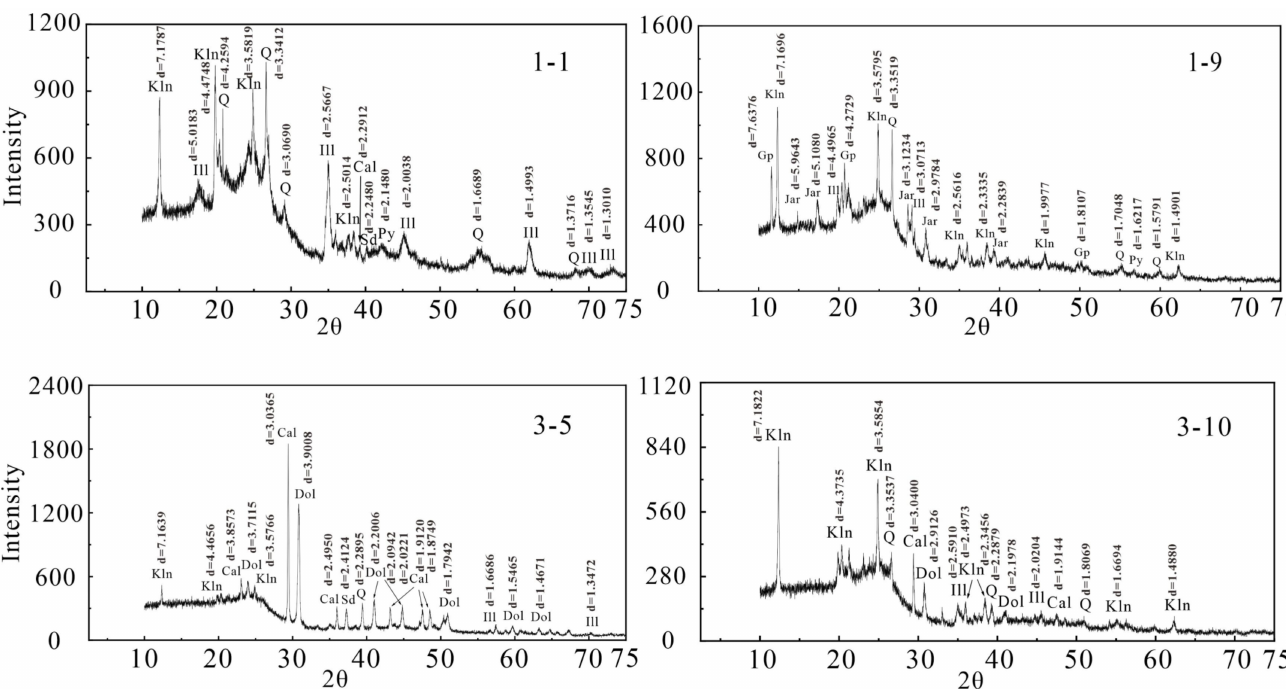
Figure 3. X-ray diffraction pattern of coal samples from Shanxi Formation in the Huainan coalfield. Kln—kaolinite; Q—quartz; Ill—illite; Cal—calcite; Dol—Dolomite; Sd—Siderite; Py—pyrite; Gp— Gypsum;